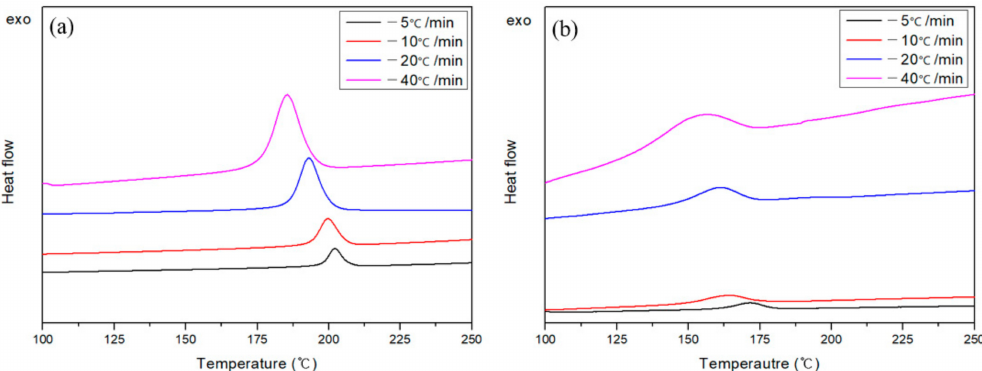
Figure 5. Differential scanning calorimeter (DSC) melt-crystallization curves of ( a ) modified PA and ( b ) Carbon/APA composite at different cooling